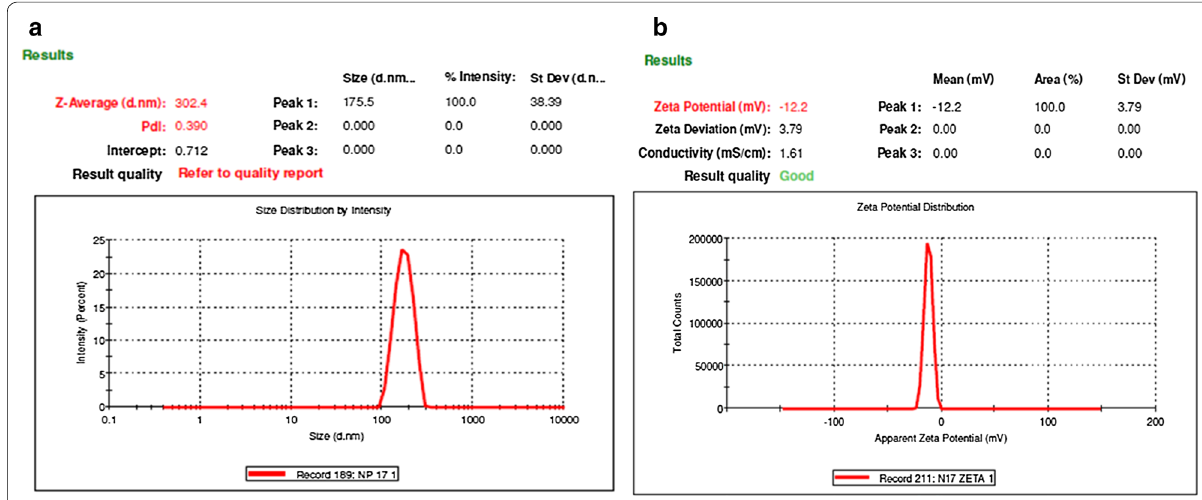
Fig. 2 a Particle size analysis of CANCs, b Analysis of Zeta potential of CANCs